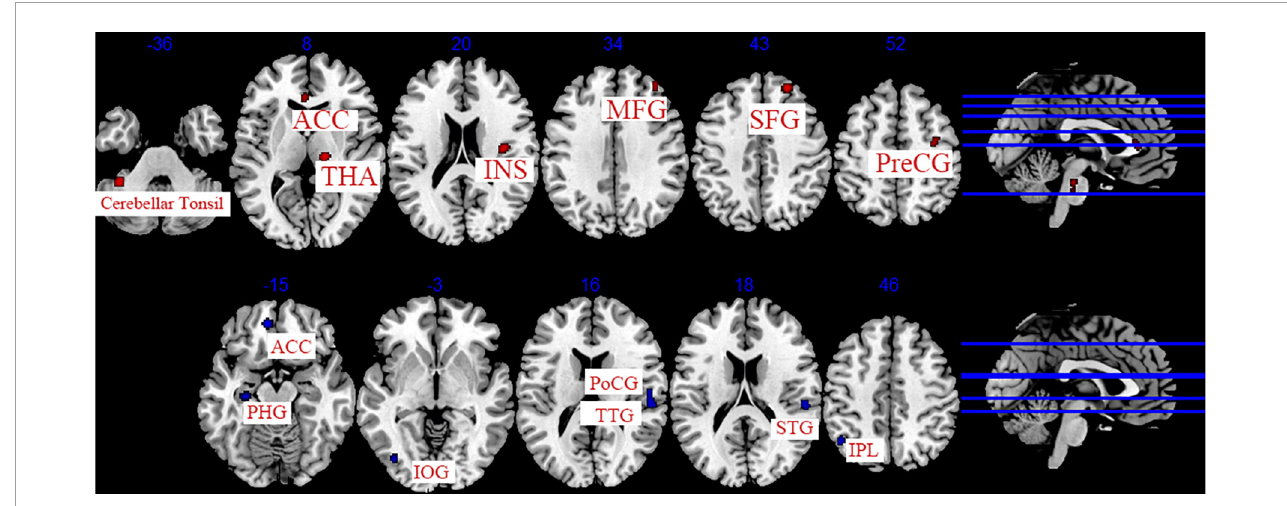
FIGURE4 Regions of brain activation in patients with pre- to post- acupuncture (cumulative effect). Red represents brain activation regions; blue represents brain deactivation